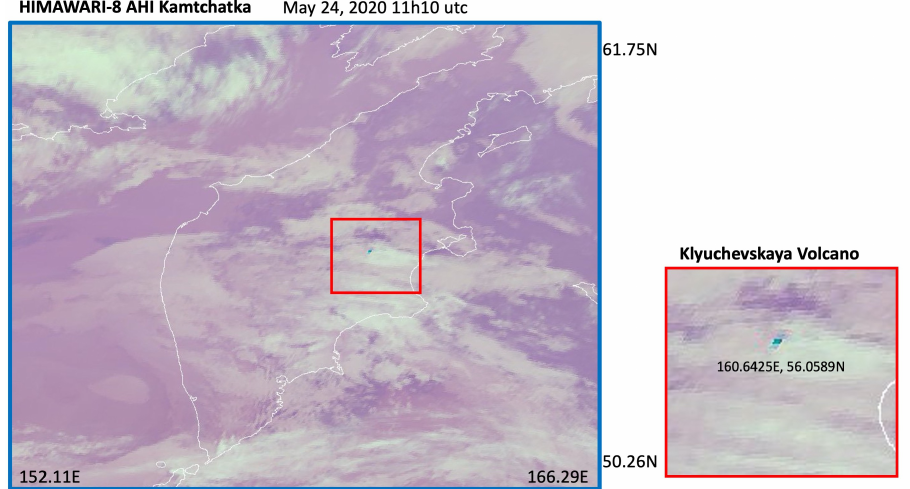
Figure 6. Night views of the active Klyuchevskaya volcano in the Kamchatka Peninsula in May 2020, captured by Himawari-8